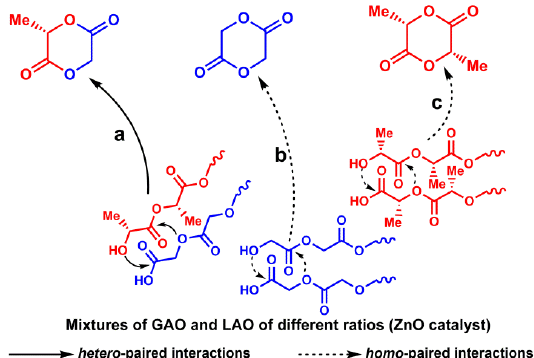
Figure 1. Intermolecular depolymerization of mechanical mixtures of GAO:LAO: hetero -paired interactions ( a ), homo -paired interactions ( b , c ).